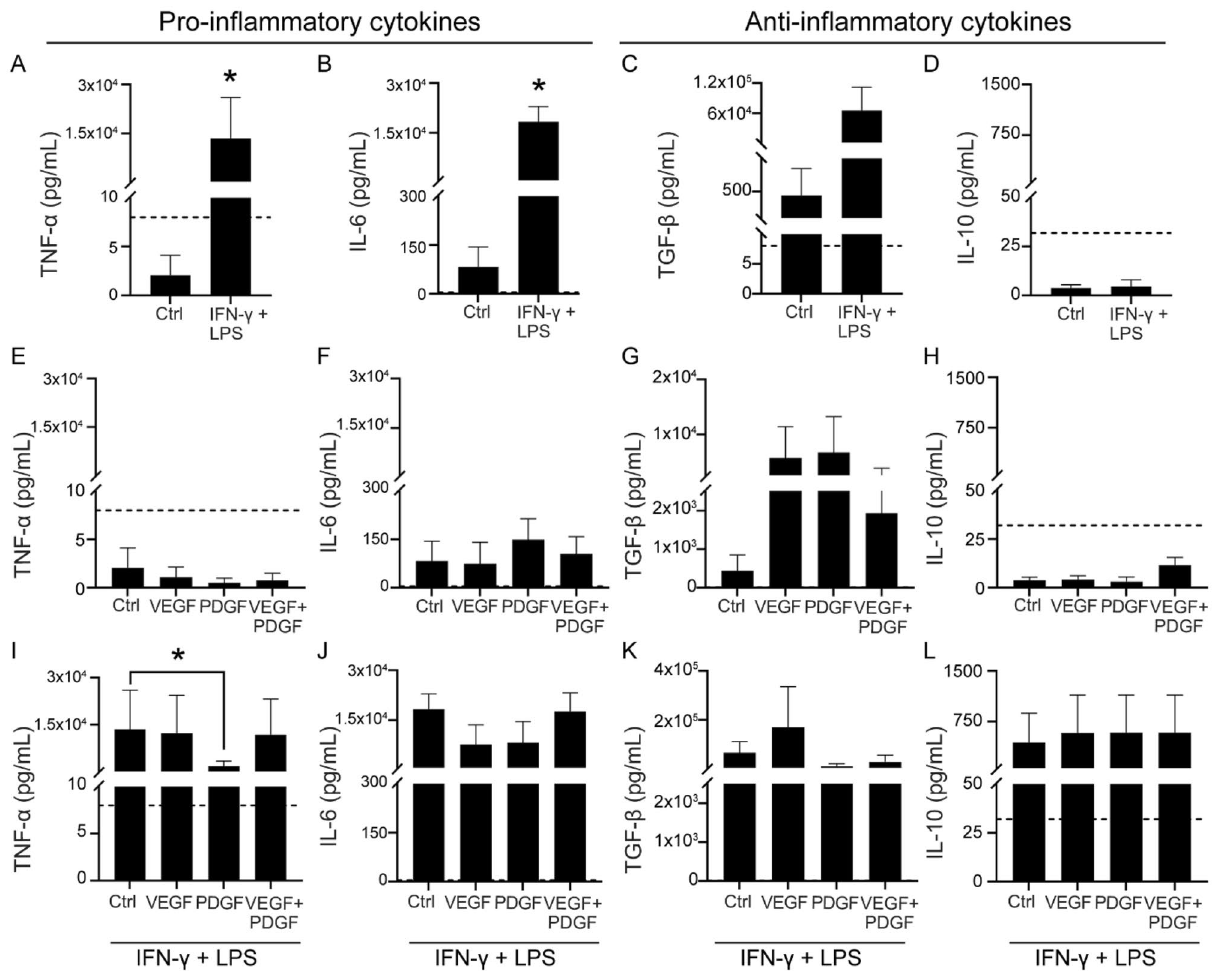
Figure 5. Effects of PDGF and VEGF on the SC cytokine profile in inflammatory and non-inflammatory conditions ( A–D ) Effects of an inflammatory environment on SC-mediated secretion of pro-inflammatory cytokines TNF-α ( A ), IL-6 ( B ) and anti-inflammatory cytokines TGF-β ( C) , IL-10 ( D ). ( E–H ) Effects of growth factors alone on TNFα ( E ), IL-6 ( F ), TGFβ ( G ) and IL-10 ( H ) cytokine levels. ( I–L ) Effects of growth factors in inflammatory environment on TNF-α ( I ), IL-6 ( J ), TGF-β ( K ) and IL-10 ( L ) cytokine levels. Dashed lines represent the lowest detectable limit of the kit for each cytokine (TNF-α, TGF-β at 8 pg/mL, IL-6 at 4 pg/mL and IL-10 at 32 pg/mL). *p ≤ 0.05, measured using Mann–Whitney U test for ( A–D ) and one-way ANOVA followed by post hoc Dunn’s test for ( E – L ). Error bar represents mean ± SEM for three technical replicates of three biological replicates. (Note: The y-axis scale of TGF-β on C , G and K are